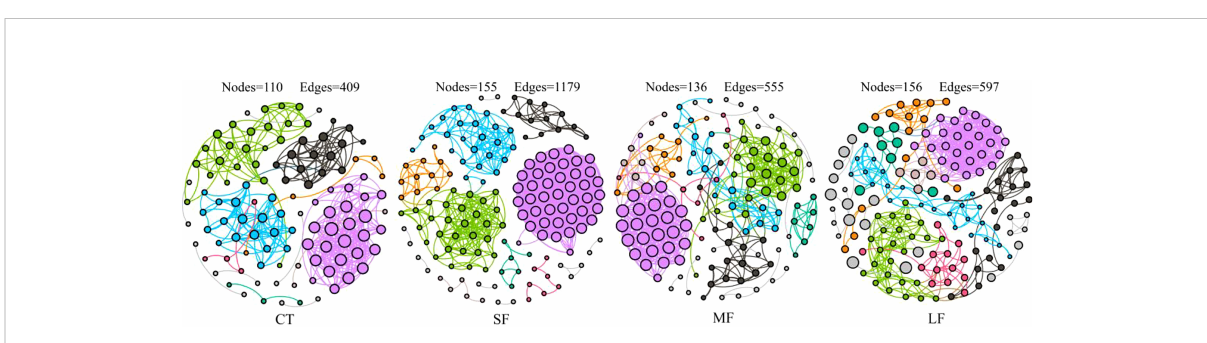
FIGURE 11 A network of relationships between gut microbial taxa of juvenile crabs at different levels of DTF (28°C, 28 ± 2°C, 28 ± 4°C, 28 ± 6°C). The size of the nodes indicates the relative abundance of OTUs, and the nodes are coloured by different modules.